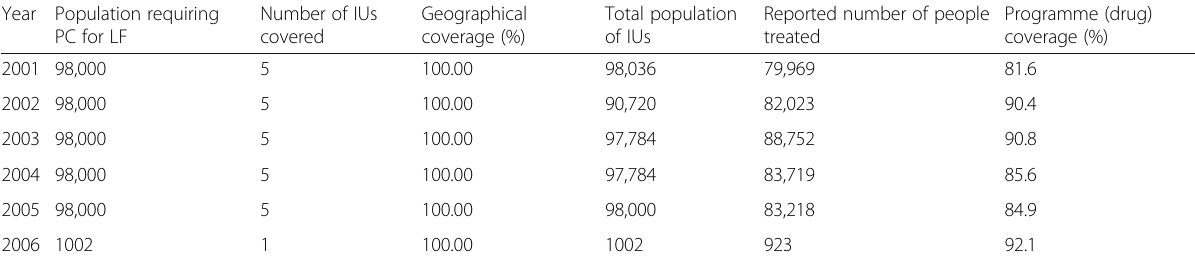
Table 3 Summary of national MDA data by year for Tonga Year Population requiring PC for LF